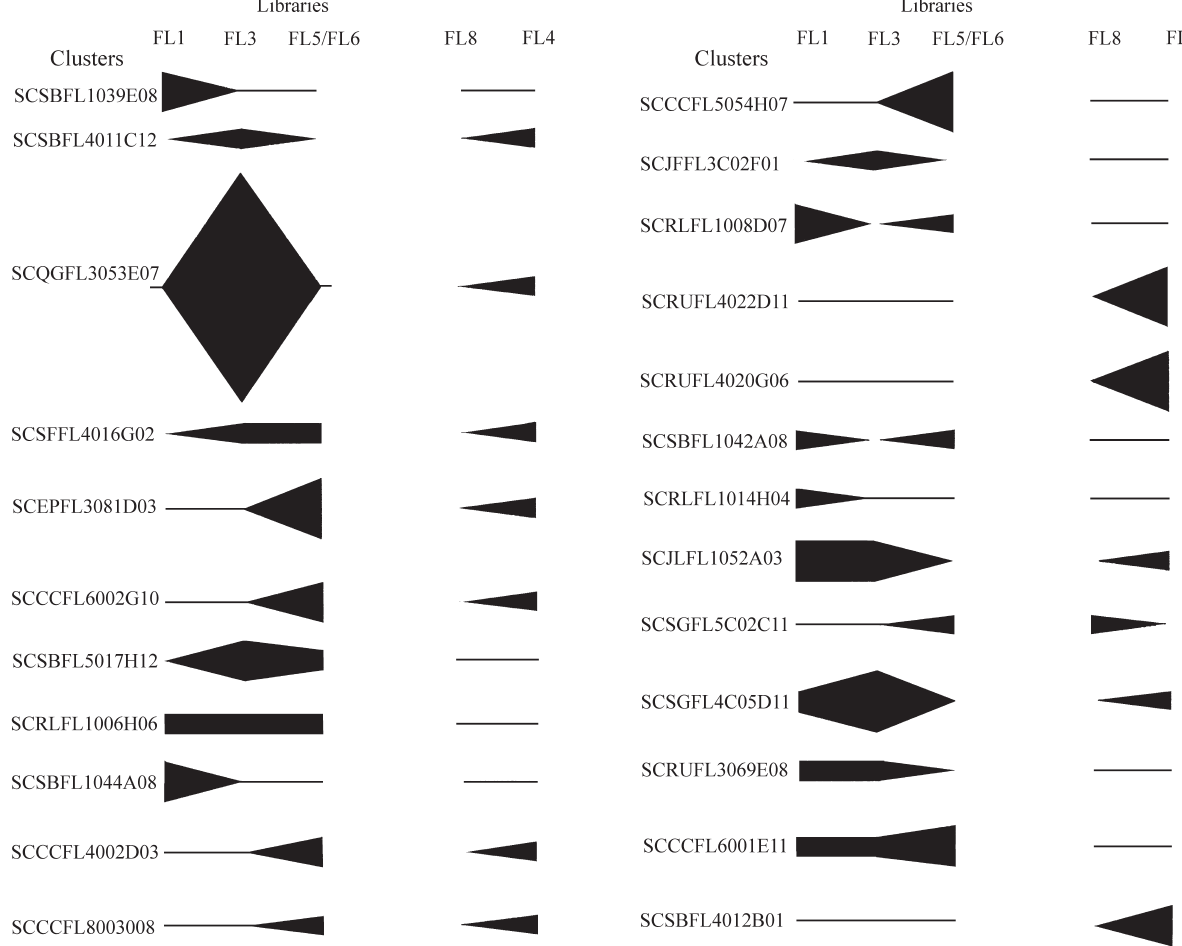
Figure2 -‘Digitalnorthernblot’ofthe24flower-specificclusters.Thefigurerepresentsgeneexpressionduringsugarcaneflowerdevelopment,basedon expressed sequence tag (EST) counts at each developmental stage as inferred from the description of the material used for the construction of the cDNA libraries. The flower cDNA libraries (FL) were prepared from 1cm sugarcane flowers (FL1), 5 cm flowers (FL3) and 20 cm flowers (FL5/FL6), while FL8 was constructed from 10 cm long flower stems and the FL4 library from 20 cm long flower stems. We considered these cDNA libraries to represent two distinct groups of flower material, which is why a virtual empty lane separates these two groups in the figure. For each cluster there is a virtual axis, the zero read position being centralized on the cluster name and represented by a straight line. The wider the area under a flower cDNA library, the higher is the expression level of the corresponding cluster in that stage of